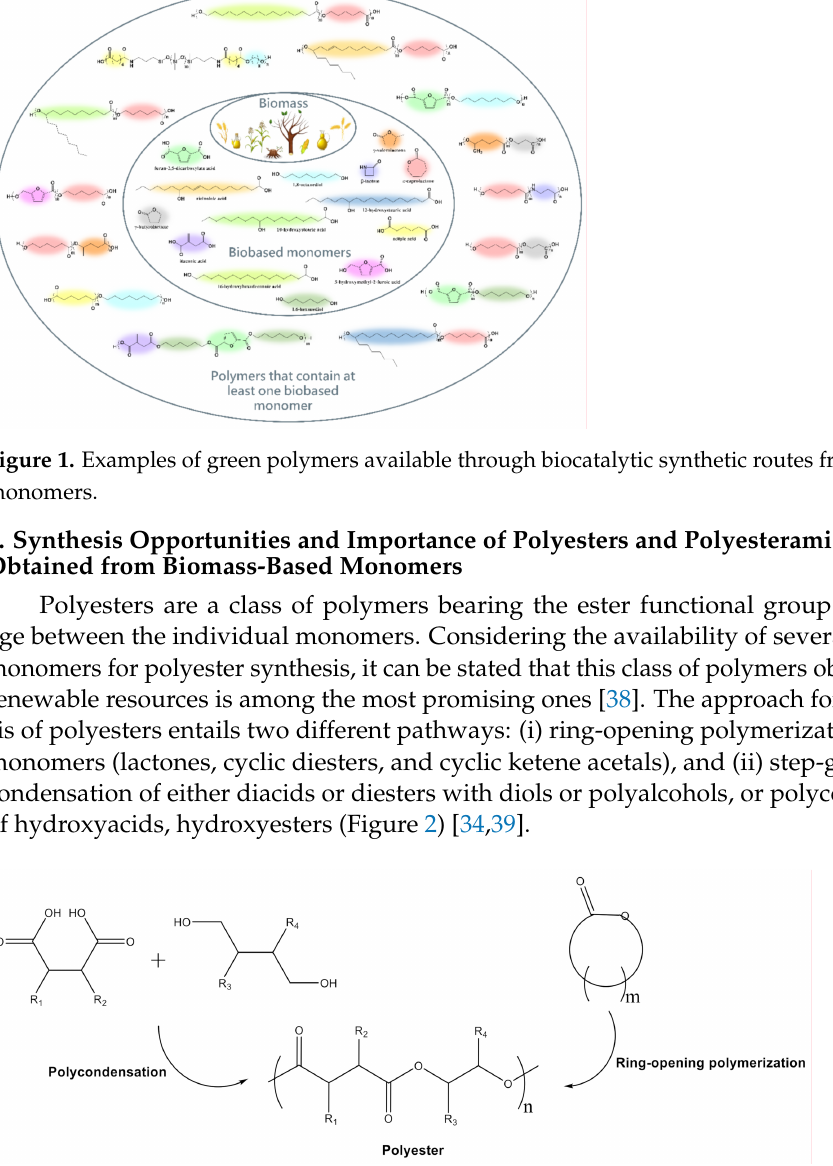
Figure 2. Pathways for polyester